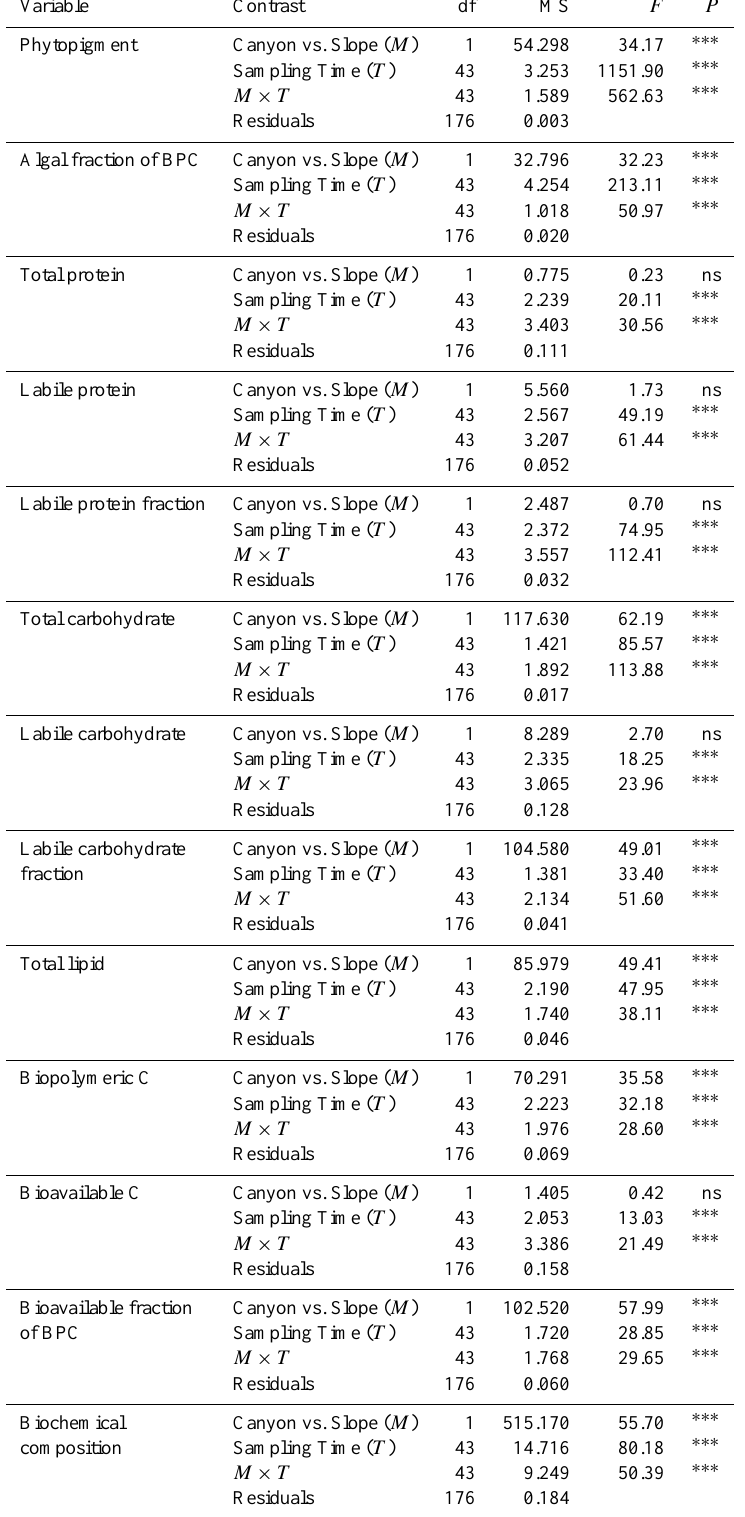
Table 2. Results of univariate and multivariate analyses of variance testing for habitat and temporal variability in fluxes and biochemical composition of fluxes in the Blanes canyon and the adjacent open slope. ∗∗∗ = P < 0.001; ns = not significant. df refers to degrees of